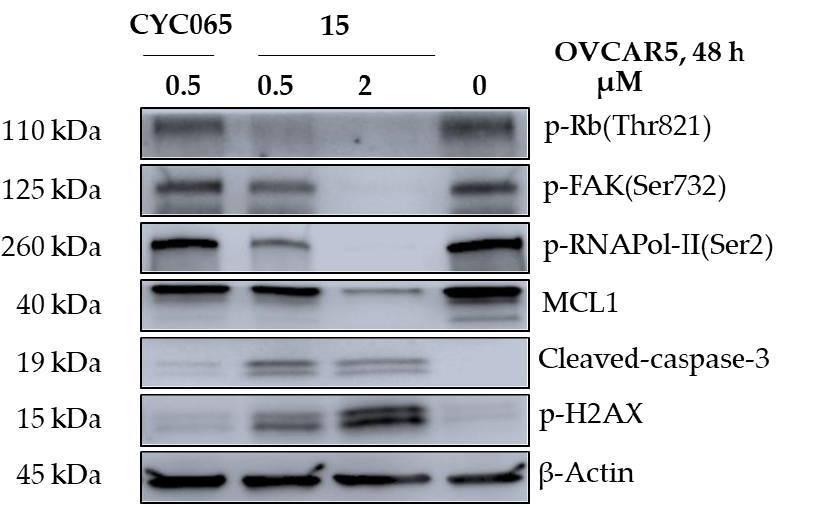
Figure 7 . Western blot analysis of OVCAR5 cells treated with 15 . Cells were exposed to 15 at 0.5 or 2 µM or to CYC065 at 0.5 µM for 48 h. DMSO diluent was employed as a control. Experiments were performed twice, and representative data are presented.